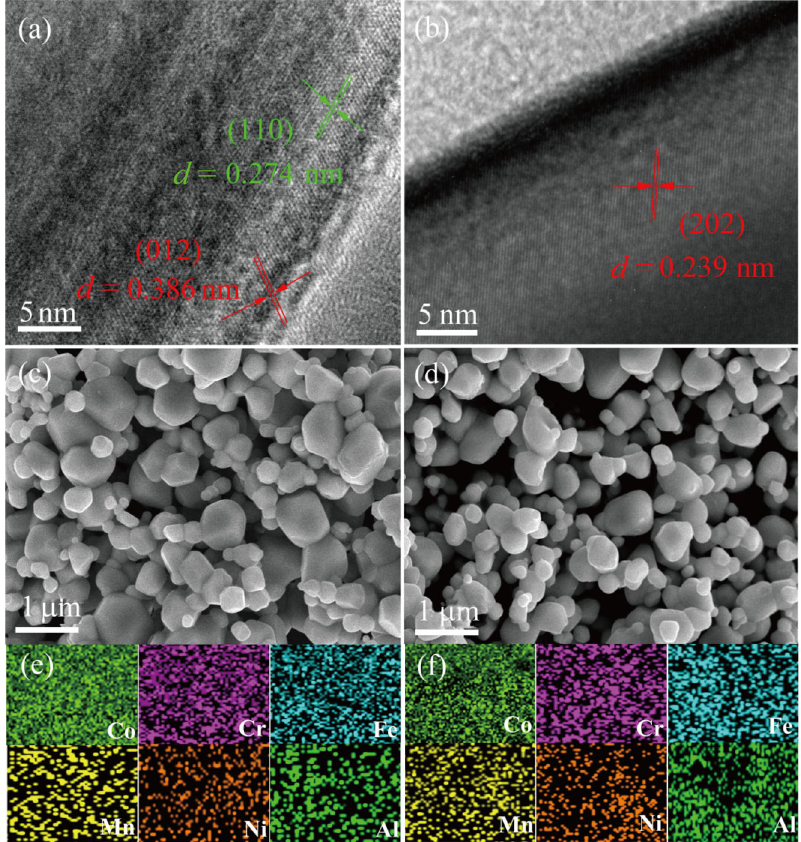
Fig. 4 HRTEM and SEM micrographs and related EDS elemental mappings for La(CoCrFeMnNiAl x ) 1/(5+ x ) O 3 − δ samples: (a–c, e) x = 0.5; (d, f) x =